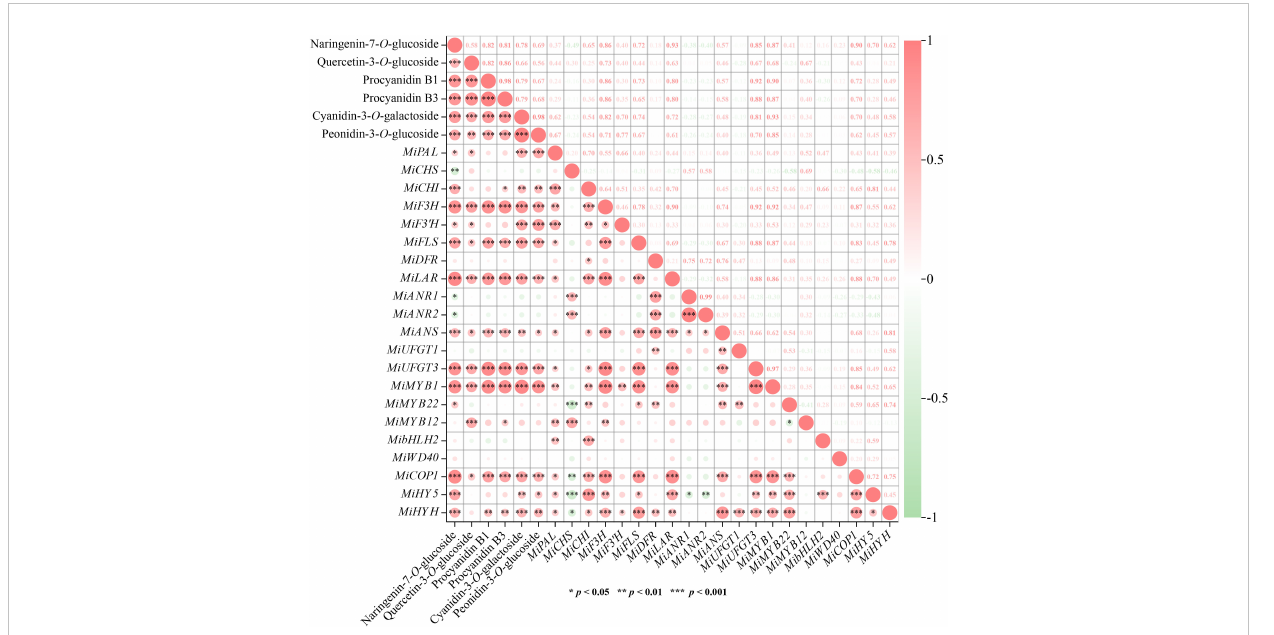
FIGURE 6 Correlation analysis among fl avonoids contents and gene expression. Positive and negative correlations are indicated by colors, with red representing positive and green representing negative (*, p < 0.05, **, p < 0.01 and ***, p < 0.001). The numbers represent the Pearson correlation coef fi cient between two